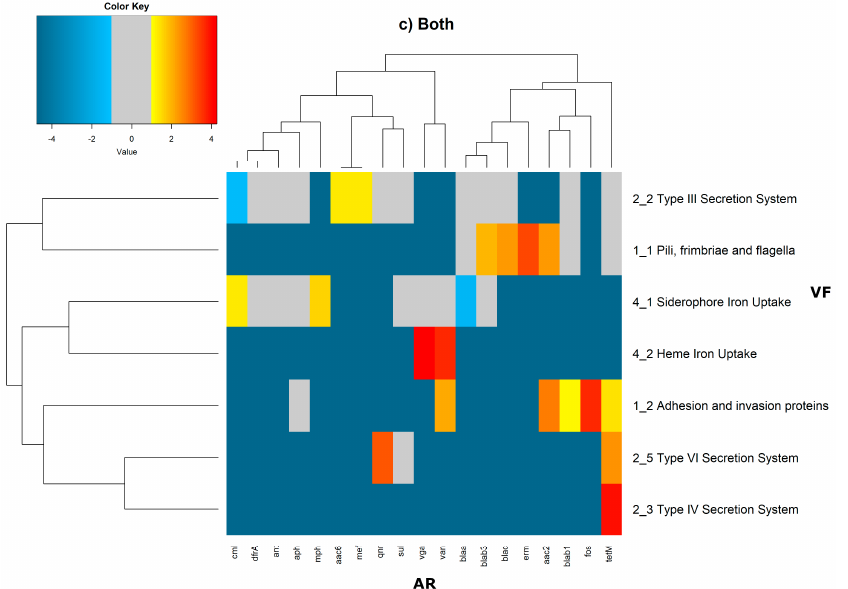
Figure 7. Heatmaps of the number of antibiotic resistance orthologues of the MUSTARD database ( x axis) and virulence factor orthologues of the VFDB database ( y axis) in each genomic position. The values correspond to the Log 2 of the quotient of observed/expected values. The yellow to red shades represent a higher-than-expected number of co-occurrences; the blue shades represent a lower-than-expected number of co-occurrences; and the grey represents values close to the expected values. ( a ) The highest number of co-occurrences of proteins orthologous to the MUSTARD database is between type VII secretion systems and the mecA antibiotic resistance gene, and between type VII secretion systems and aac2 . ( b ) In plasmids, the highest number of co-occurrences appear to involve type VII secretion systems and toxins. ( c ) The ‘both’ genomic position has the lower number of co-occurrences; there is a more diverse pattern of co-occurrences. We observed no co-occurrence involving six out of thirteen orthologues of virulence genes.